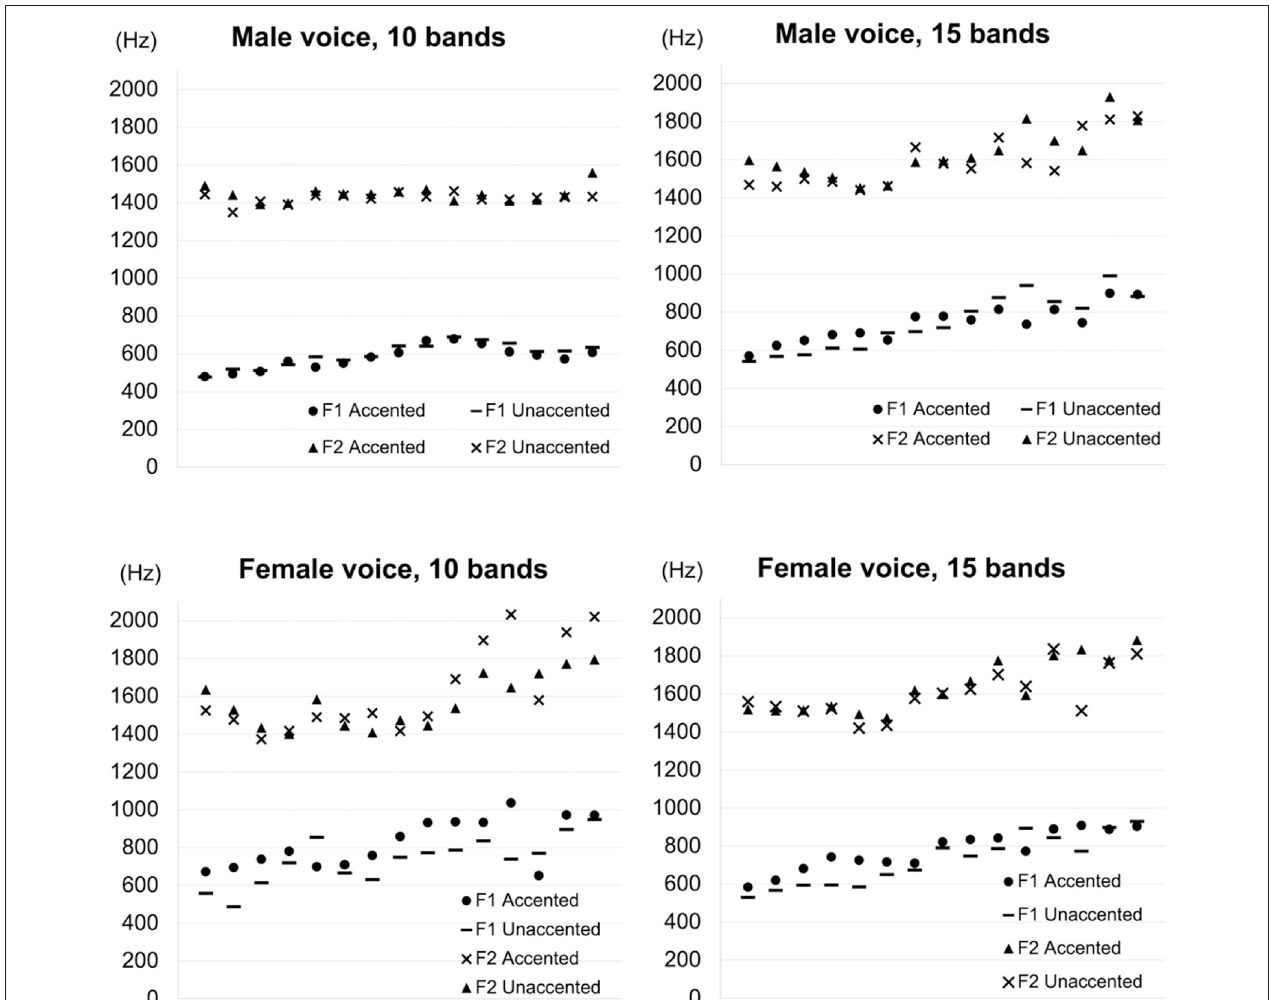
FIGURE 11 | First formant frequencies (F1) and second formant frequencies (F2) of the particle for the 10 band stimuli and the 15 band stimuli for the male and female voices, normalized by the entire duration of the particle. In the legend, “Accented” indicates frequency values following final-accented words. “Unaccented” indicates frequency values following unaccented